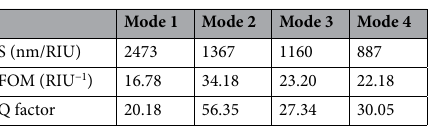
Table 2. The S, FOM, and Q factor of case 3 structure from mode 1 to mode